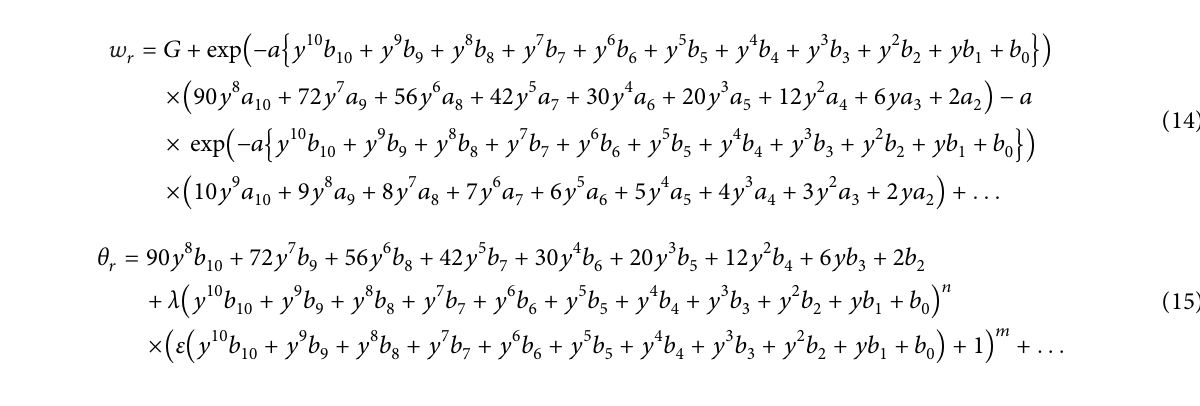
Figure 6: Heat field for rising values of Q .